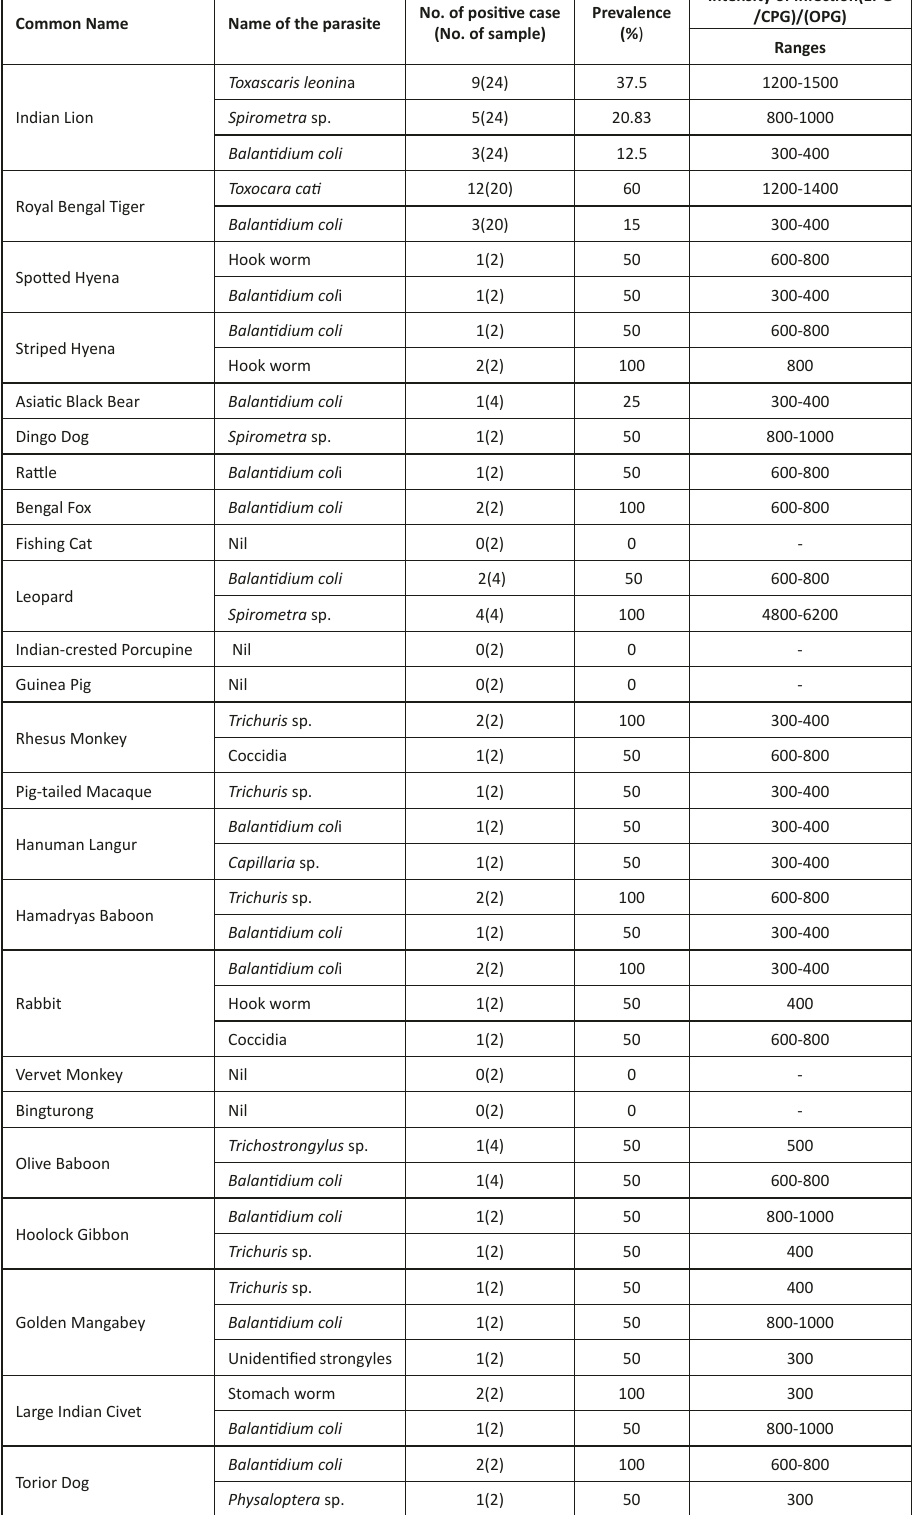
Table 1. Prevalence and intensity of ova/cyst/oocysts of different parasites in different animals at Dhaka